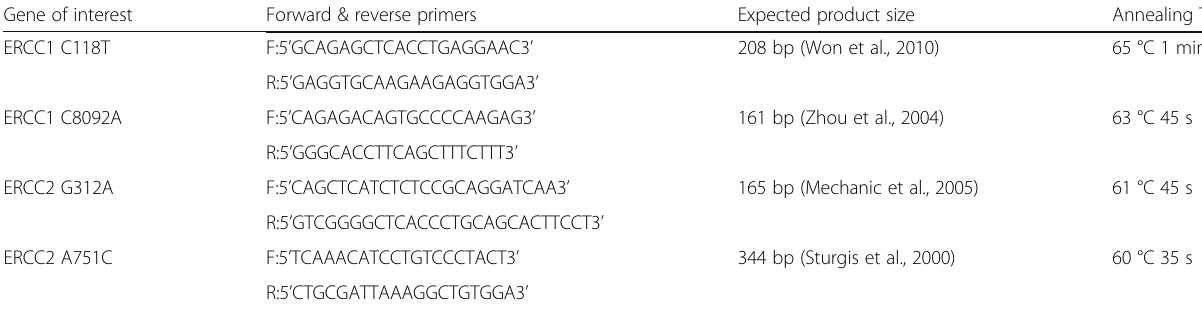
Table 1 Primers sequences and the expected product size Gene of